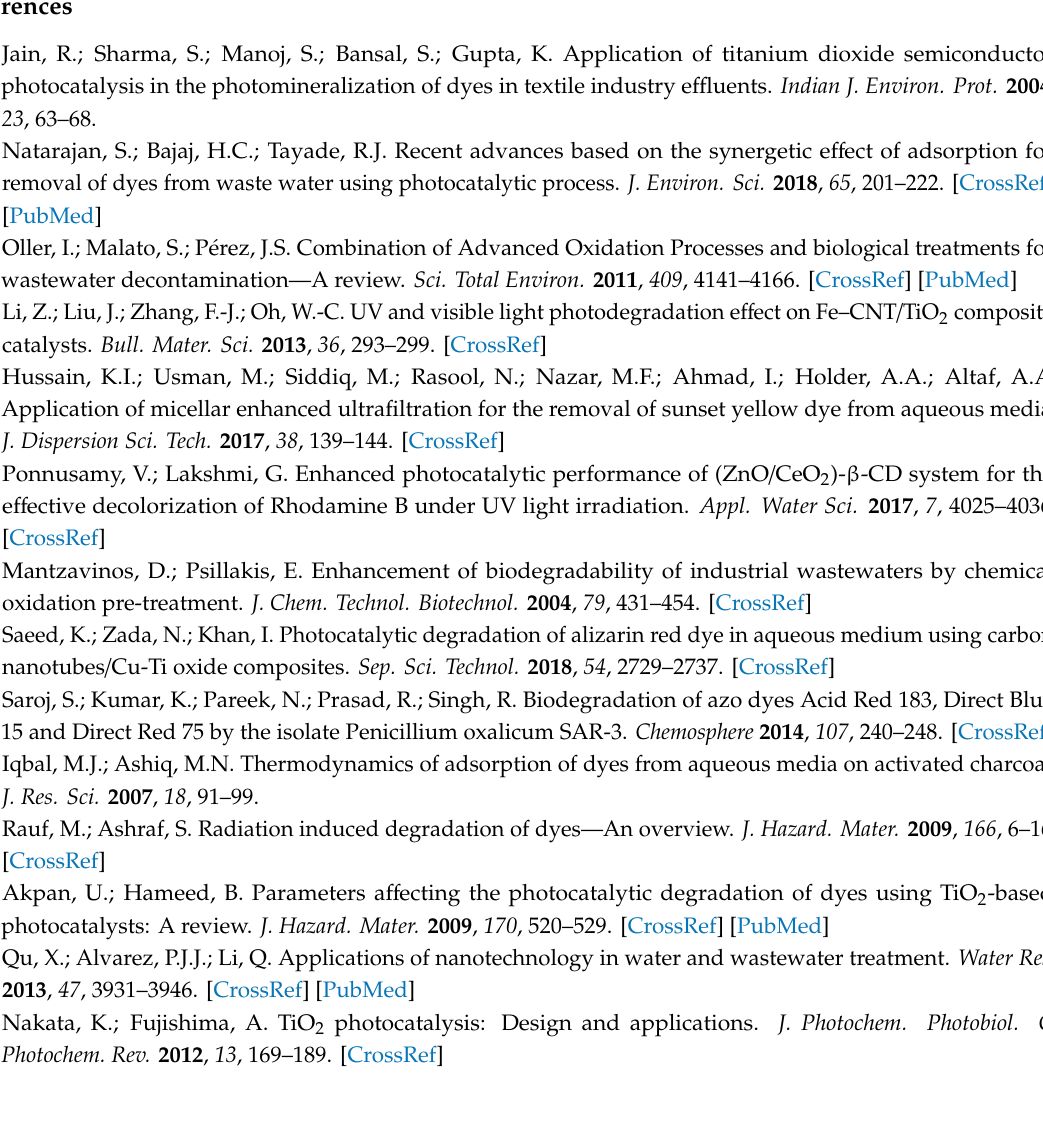
Figure S11: Correlation between Alizarin Red (AR) Dye Concentration after 60min of Photocatalytic Activity by Nanomaterials (MH1-MH5) at Di ff erent Dye Concentrations; Figure S12: Correlation between Alizarin Red